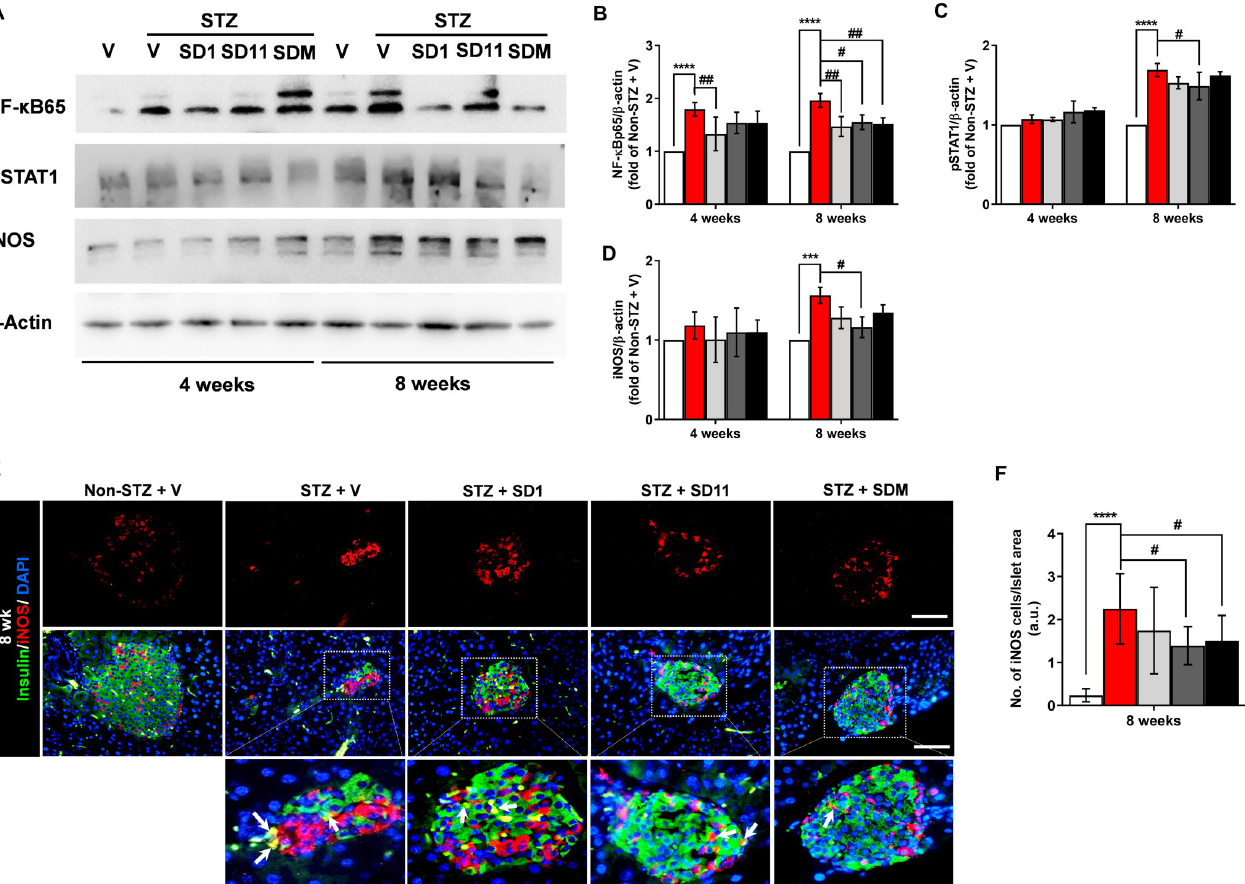
Fig 6. Probiotics counteract the cytokine-induced β -cell toxic signaling pathway. (A) Representative images of pancreatic protein expression of NF- κ Bp65, pSTAT1, and iNOS were measured by Western blotting. Densitometry quantification of (B) NF- κ Bp65, (C) pSTAT1, and (D) iNOS normalized to β -actin. (E) Representative immunofluorescent images of the M1 polarized macrophage marker iNOS (red), β -cell marker insulin (green) and DAPI (blue) staining in sections of formalin-fixed paraffin-embedded among experimental groups at 8 weeks. White arrows indicate localization of insulin- and iNOS-positive cells. (F) Quantification of the number of iNOS-positive cells/islet area. All images were taken at 400 magnification. Scale bars, 50 μ m. Data represent the mean ± SEM. N = 3 for Western blot assay. A measurement of 50 independent islets per group (10 islets per mouse pancreas were randomly chosen from 5 animals per group) was examined for immunostaining. **** P < 0.0001, *** P < 0.001 vs. the corresponding non-STZ group; ## P < 0.01, # P < 0.05 vs. the corresponding vehicle-treated STZ group.